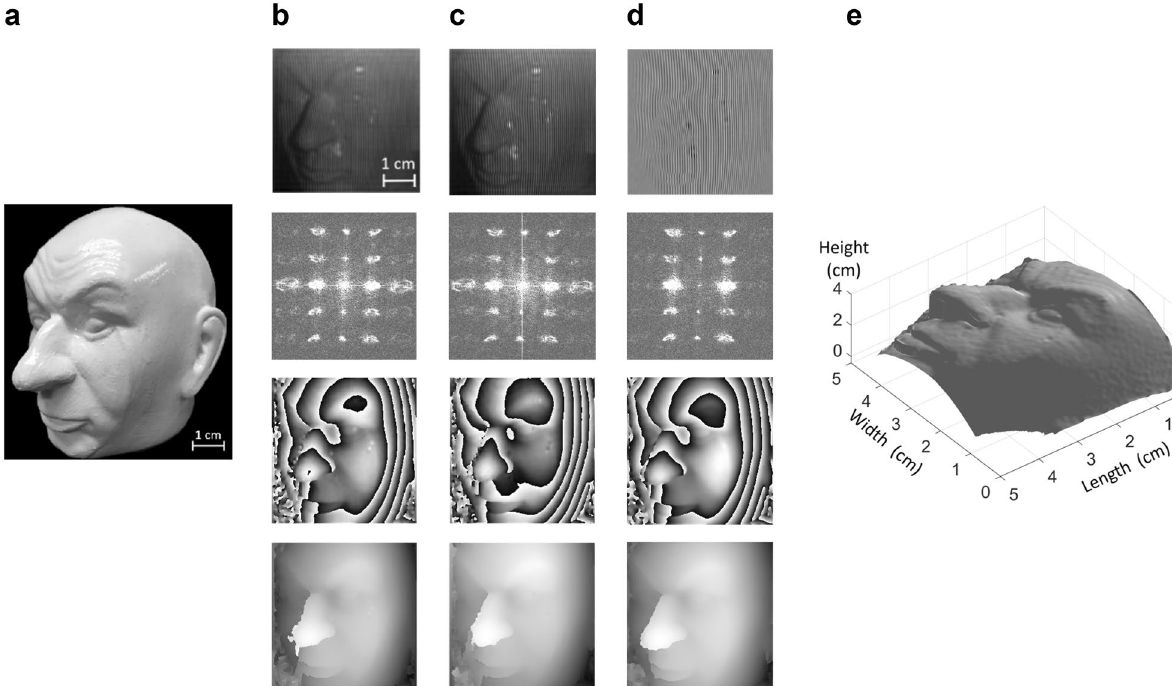
Figure 3. Phase demodulation for a head phantom. ( a ) Photograph of the head phantom. ( b ) Vertical fringe pattern acquired with MFPP method (top), the 2D frequency spectrum of the fringe pattern (second from top), wrapped phase computed from 2D frequency spectrum (second from bottom), and unwrapped phase (bottom) computed from the wrapped phase. ( c ) Similar to ( b ), except results are for the vertical π-phase shifted fringe pattern complementary to ( b ). ( d ) Similar to ( b ), except results are for the differential fringe pattern computed by subtracting the fringe pattern in c from the fringe pattern in ( b ). ( e ) 3D visualization of the object computed from the unwrapped phase in ( d ) after applying phase to height conversion.